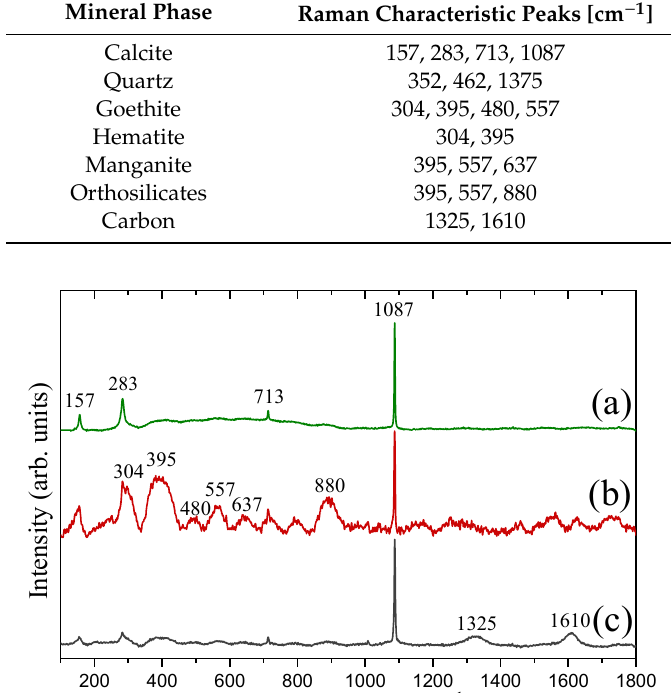
Table 4. The tentative assignment of the observed Raman lines to the different mineral phases of the mosaics fragments.